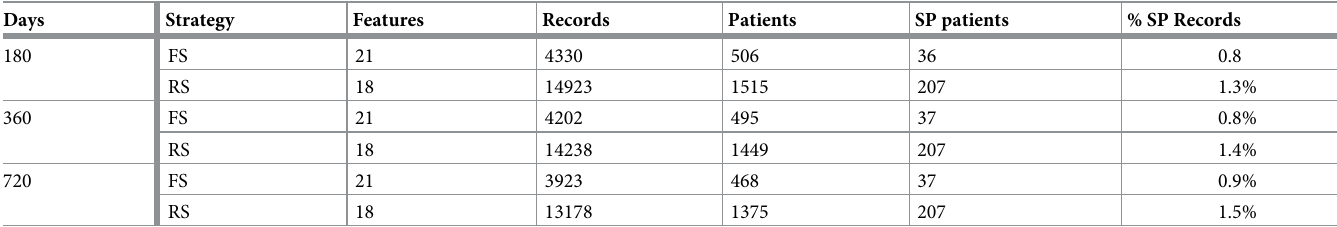
Table 3. Composition of the Feature-saving and Record-saving